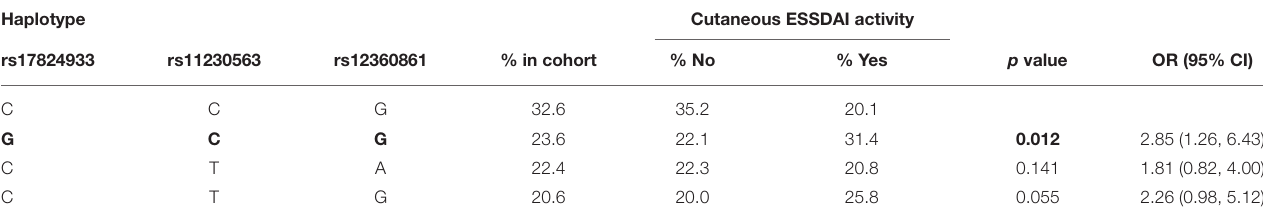
TABLE 5 | Logistic regression analysis of CD6 haplotype association to cutaneous affectation. Only the 4 most common haplotypes are shown.